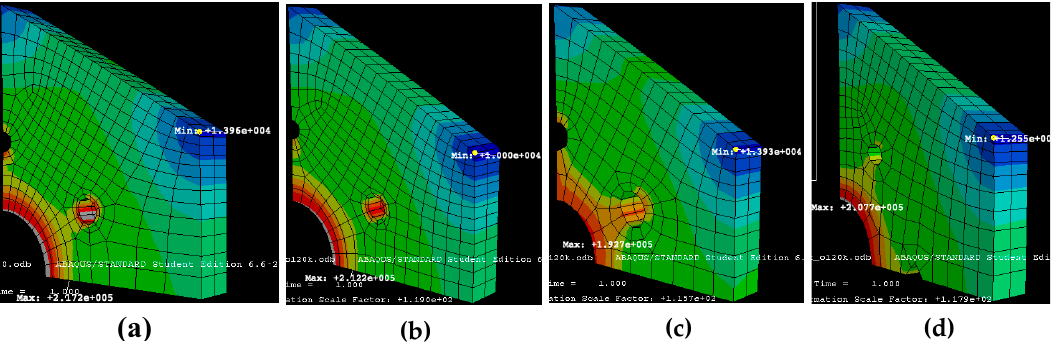
Figure 15. FEA of a hexagonal PM for ω = 120 krpm, R = 25 mm, r = 5 mm, and b = 10 mm. Variation with regard to the radius of the circle on which the centers of the supplemental holes are placed, R h , from ( a ) 13 mm to ( b ) 14 mm; with regard to the diameter δ of these holes from ( a ) δ = 2 mm to ( c ) δ = 3 mm; with regard to the situation when these holes are placed in the direction of the PM apex ( a ) versus in the direction of the middle of PM facets ( d ).